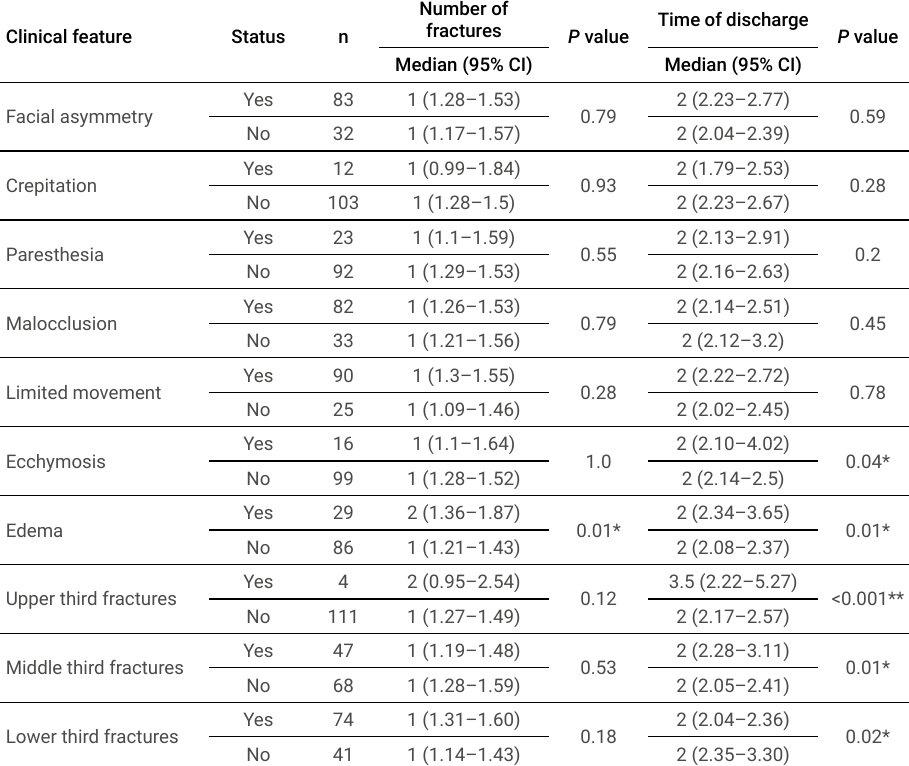
Table 6. Difference of medians of the number of fractures and time of hospital discharge according to the clinical features in maxillofacial trauma patients.